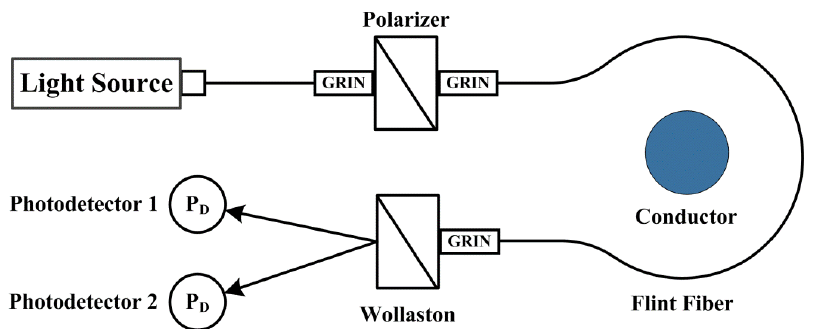
Figure 7. Typical configuration of an optical current sensor with flint